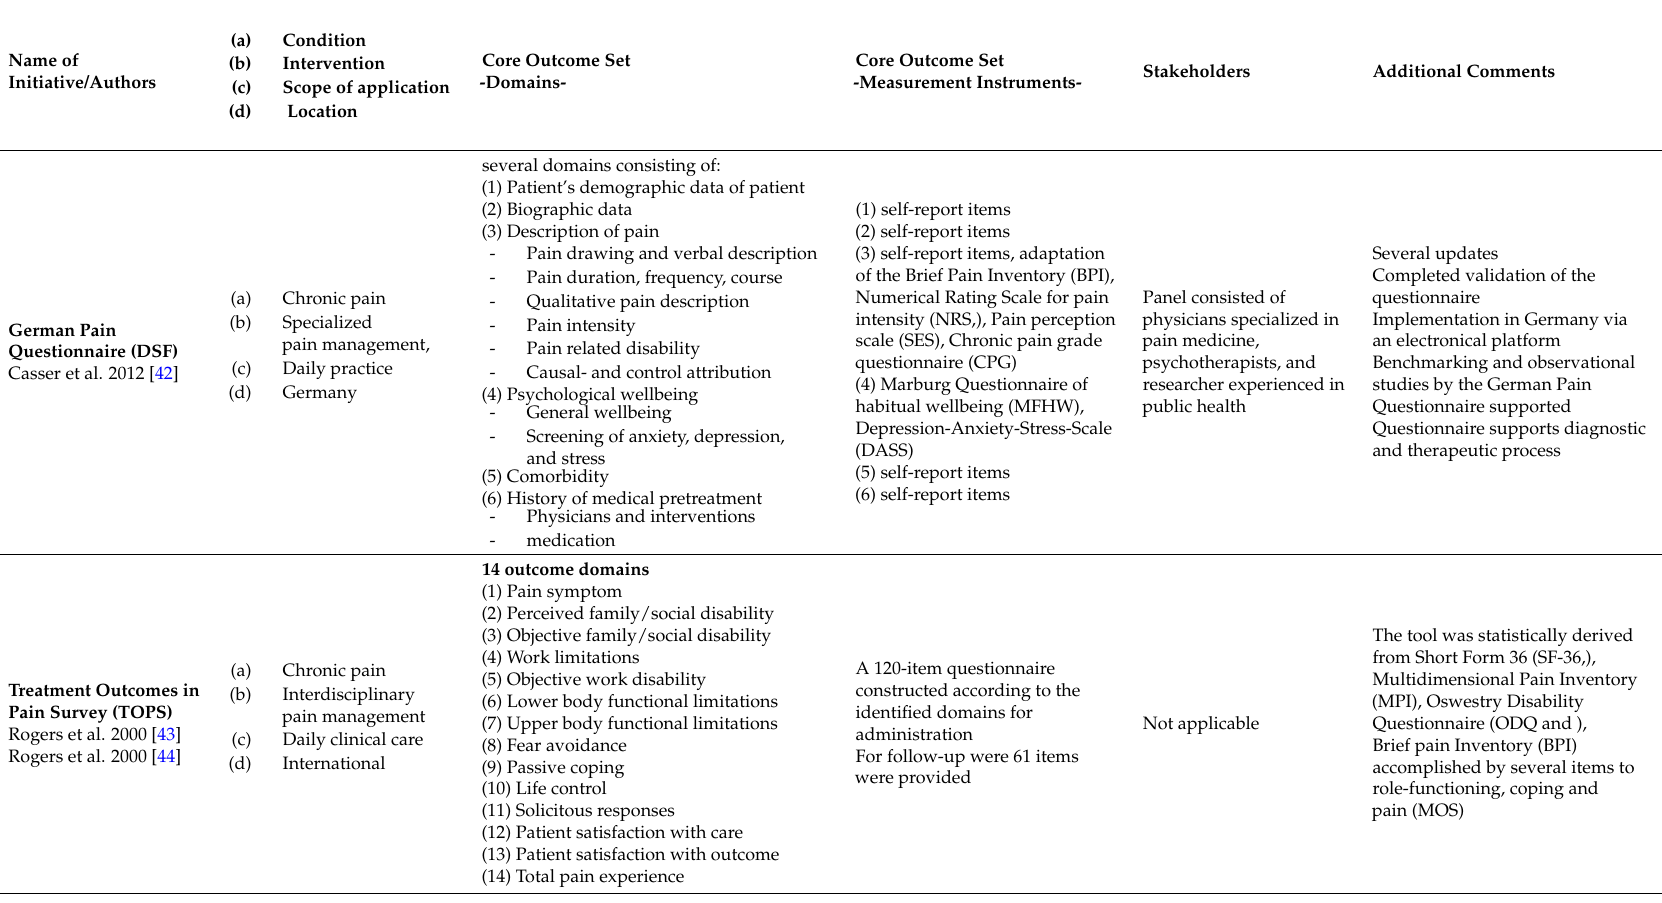
Table 2. Recommendations for core outcome sets for daily record keeping in chronic pain and back